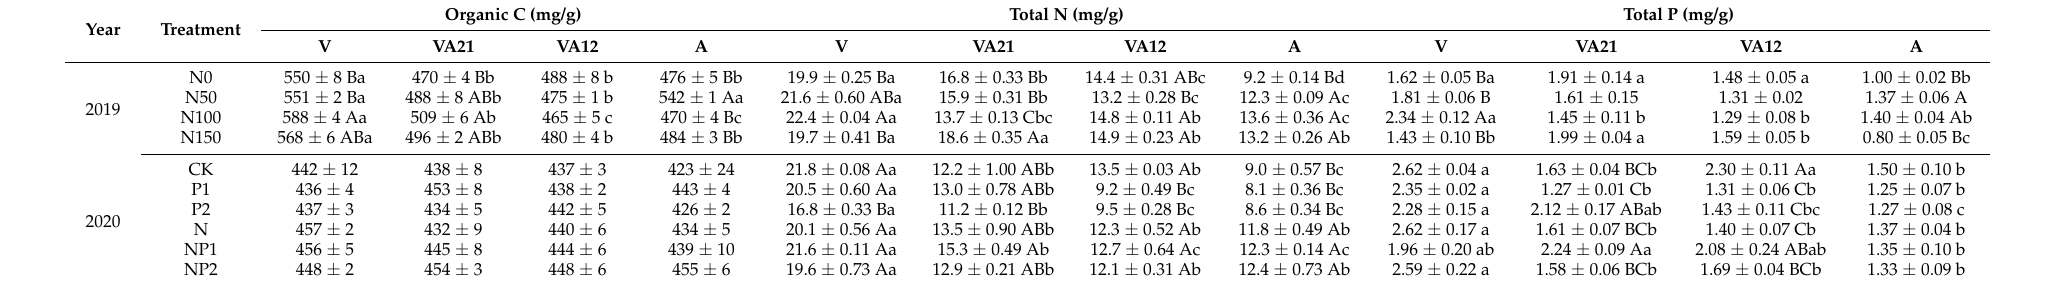
Table 4. Root C, N, and P concentrations under different fertilization rates and mixing ratios in 2019 and